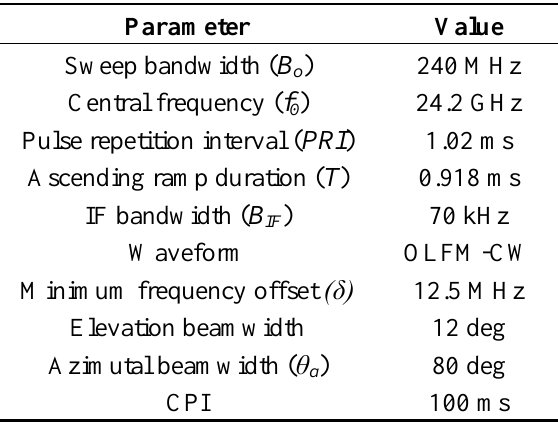
Table 1. Radar network